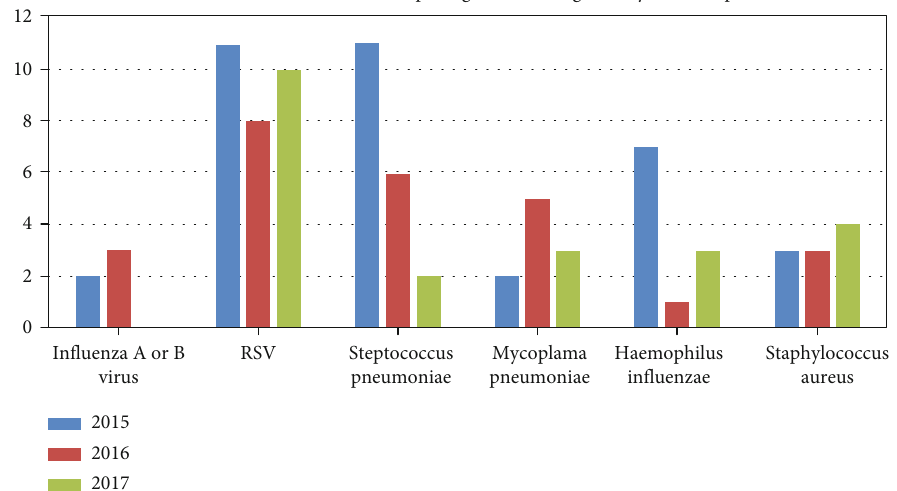
Figure 4: Distribution of the 6 main identi fi ed pathogens according to the year of hospitalization.